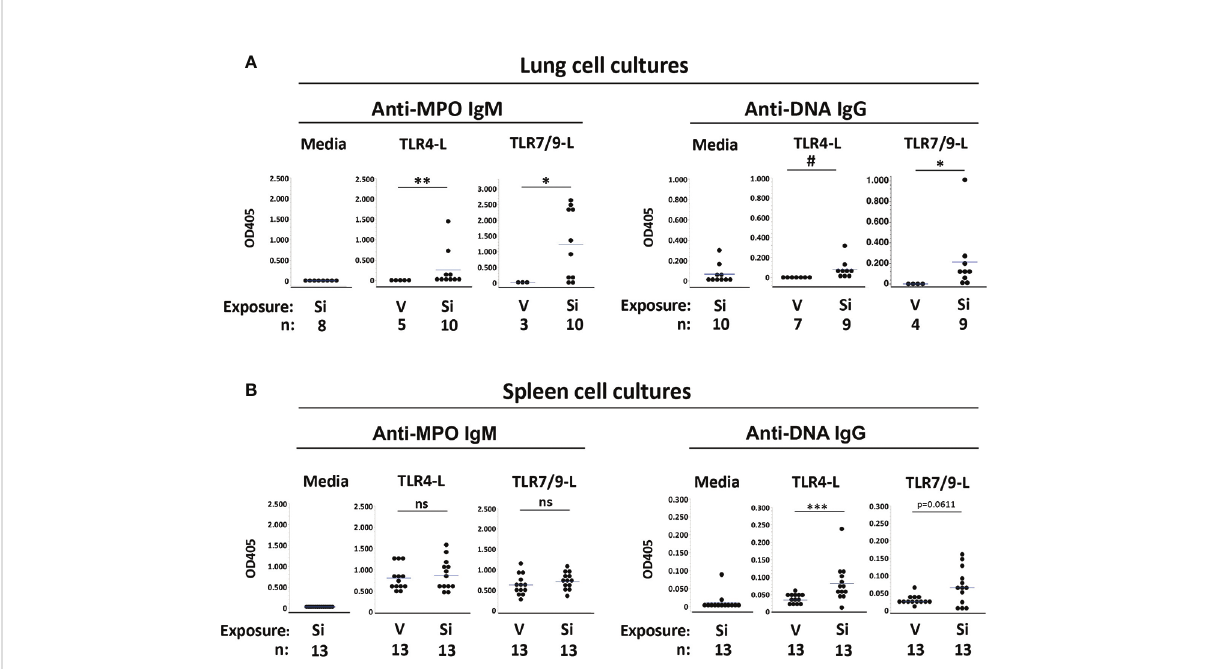
FIGURE 2 Autoantibodies produced by cultured lung and spleen cells from female BXSB mice exposed to respiratory crystalline silica or vehicle, with or without intraperitoneal lipopolysaccharide (LPS). Culture supernatants from isolated (A) lung cells and (B) splenocytes were assayed for anti- MPO IgM and anti-ssDNA IgG levels. Cells were cultured with medium alone or with either TLR4 ligand (TLR4-L) LPS or a mixture of TLR7 and TLR9 ligands (TLR7/9-L) R848 and CpG oligos, from mice of indicated exposure. Results are shown for all exposed mice, including those with or without i.p. LPS administered 1-2 days prior to organ harvest. Each circle represents an individual mouse; the bar indicates the mean for each group; *p < 0.05; **p < 0.01; ***p < 0.001; # p < 0.005; ns, not signi fi cant; for silica- vs. vehicle-exposed mice, Wilcoxon rank sum